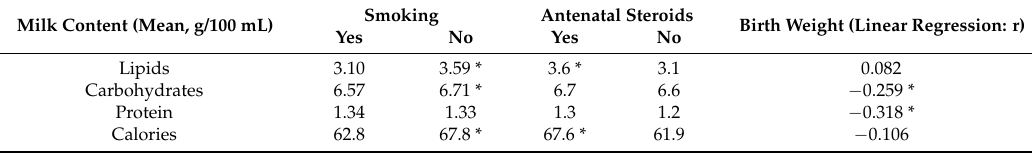
Table 3. Confounding perinatal factors for milk composition.